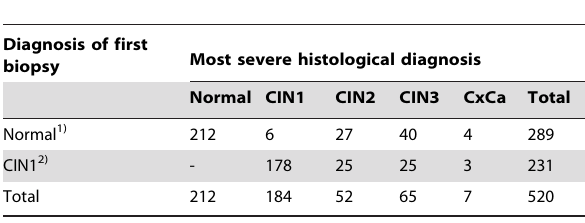
Table 7. Diagnosis of the first cervical biopsy compared to the most severe histological diagnosis.